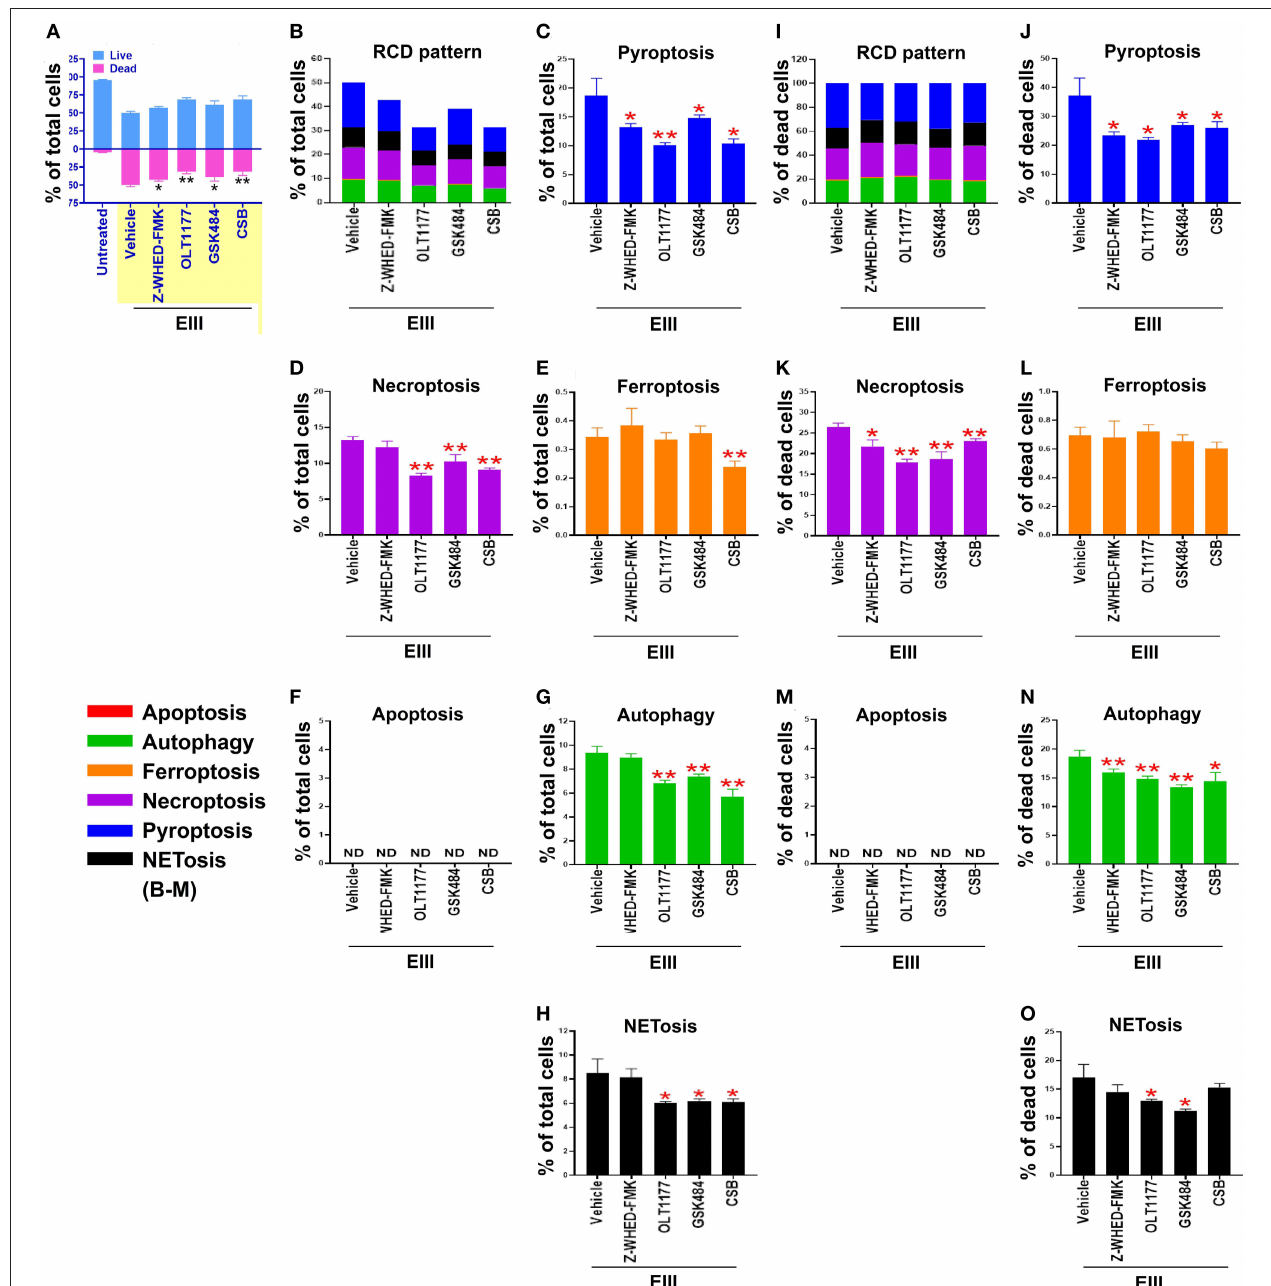
FIGURE 4 | Protection of neutrophils from rEIII-induced pyroptosis under treatment with Nlrp3 inflammasome inhibitors. Pre-treatments (30min) with NETosis inhibitor GSK484 (2nM), Nlrp3 inhibitor OLT1177 (10 µ M), and caspase 1 inhibitor Z-WHED-FMK (10 µ M) on the rescue of rEIII-induced neutrophil total cell death (A) . Pretreatments (30min) with Nlrp3 inflammasome inhibitors OLT1177, Z-WHED-FMK, and NETosis inhibitor GSK484 rescued rEIII-induced (1h) neutrophil pyroptosis (B,C) , necroptosis (D) , autophagy (G) and NETosis (H) , but not ferroptosis and apoptosis (E,F) . If the respective RCD% was normalized by the population of death cells [ (I) : dead cell population normalized to 100%], we found that CSB, OLT1177 and Z-WHED-FMK still display rescue effects on pyroptosis (J) , necroptosis (K) , autophagy (N) , and NETosis (O) , but not ferroptosis and apoptosis (L,M) . Chondroitin sulfate B (CSB, 10 µ g/mL), a competitive inhibitor against rEIII binding (33), serving as a positive inhibitor control to inhibit cell death. n = 6, * P < 0.05, ** P < 0.01, vs. respective vehicle groups. ND, not detected.